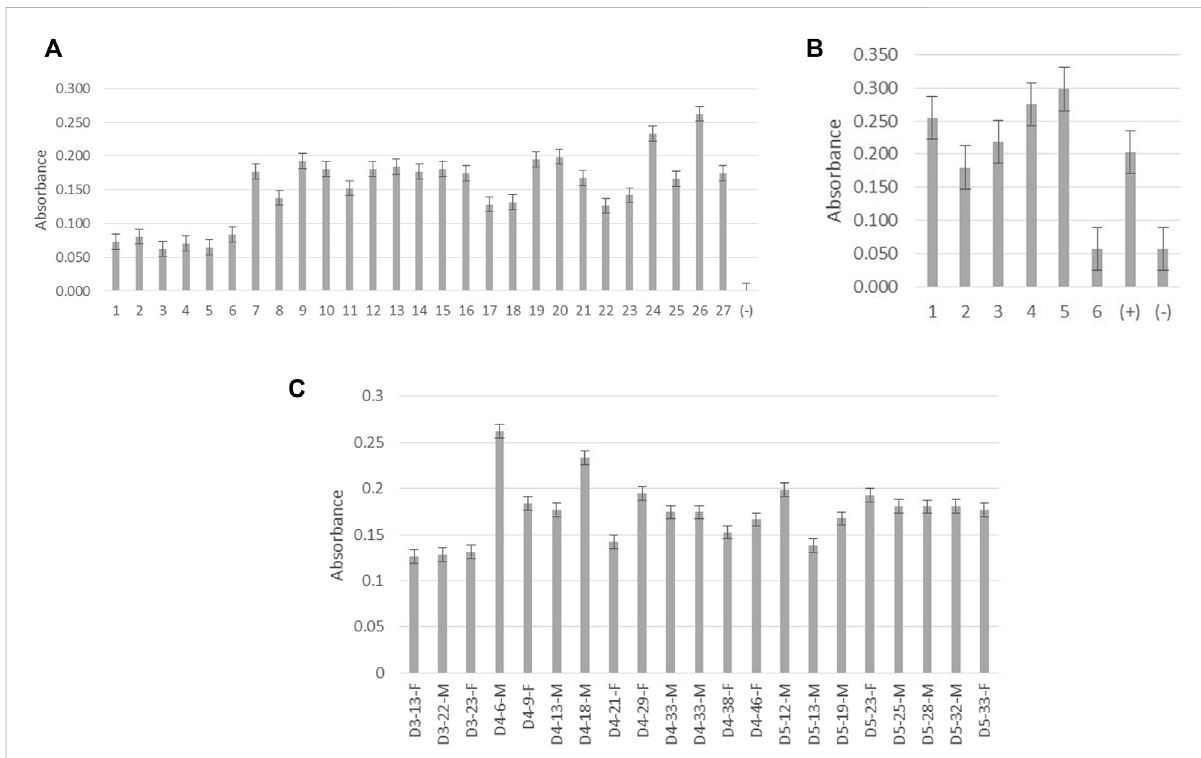
FIGURE 4 ScreeningofmonoclonalantibodyP1-18forreactivitywithnativeDENVNS1protein. (A) AbsorbancemeasurementsofP1-18antibodyreacting withpatientserumsamples.Columns1 – 6denotesamplesfromdengue-negativepatientswithfebrileillnesses.Columns7 – 27denotesamplesfrom dengue-positive patients. Column ( − ) represents the blank (B) Absorbance measurements of P1-18 antibody reacting with patient urine samples. Columns1 – 5denotesamplesfromdengue-positivepatients.Column6denotesasamplefromdengue-negative/healthyindividuals.Columns (+) represent dengue-positive serum samples and column ( − ) denotes the blank. (C) Absorbance measurements of P1-18 antibody reacting with patientserumsamplesagainstdaysoffever(DOF),age(inyears),andgender(female:Fandmale:M).Alltheabsorbancemeasurementsweretakenat 450 nmwavelength.D3representsthethirddayfromtheonsetoffever,D4representsthefourthdayfromtheonsetoffever,andD5representsthe fi fth day from the onset of fever. Error bars represent the standard deviation ( n =